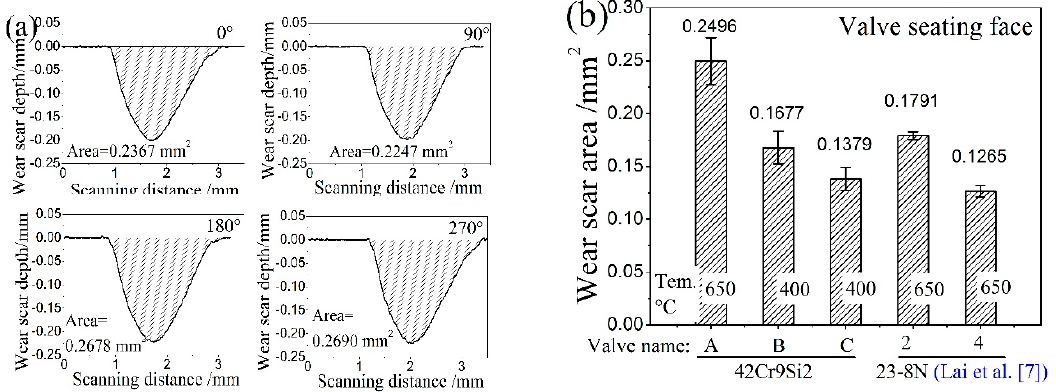
Figure 18. ( a ) Wear scar profiles valve A at four measured positions; ( b ) the comparison of wear scar area of five HHSVs.